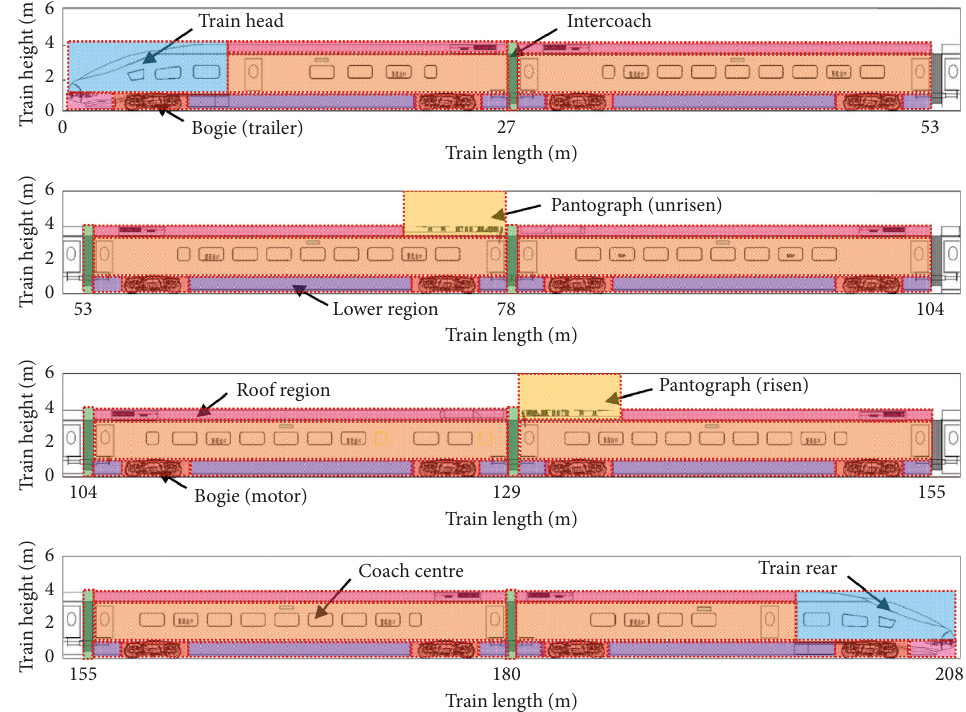
Figure 7: Divided regions of the entire high-speed